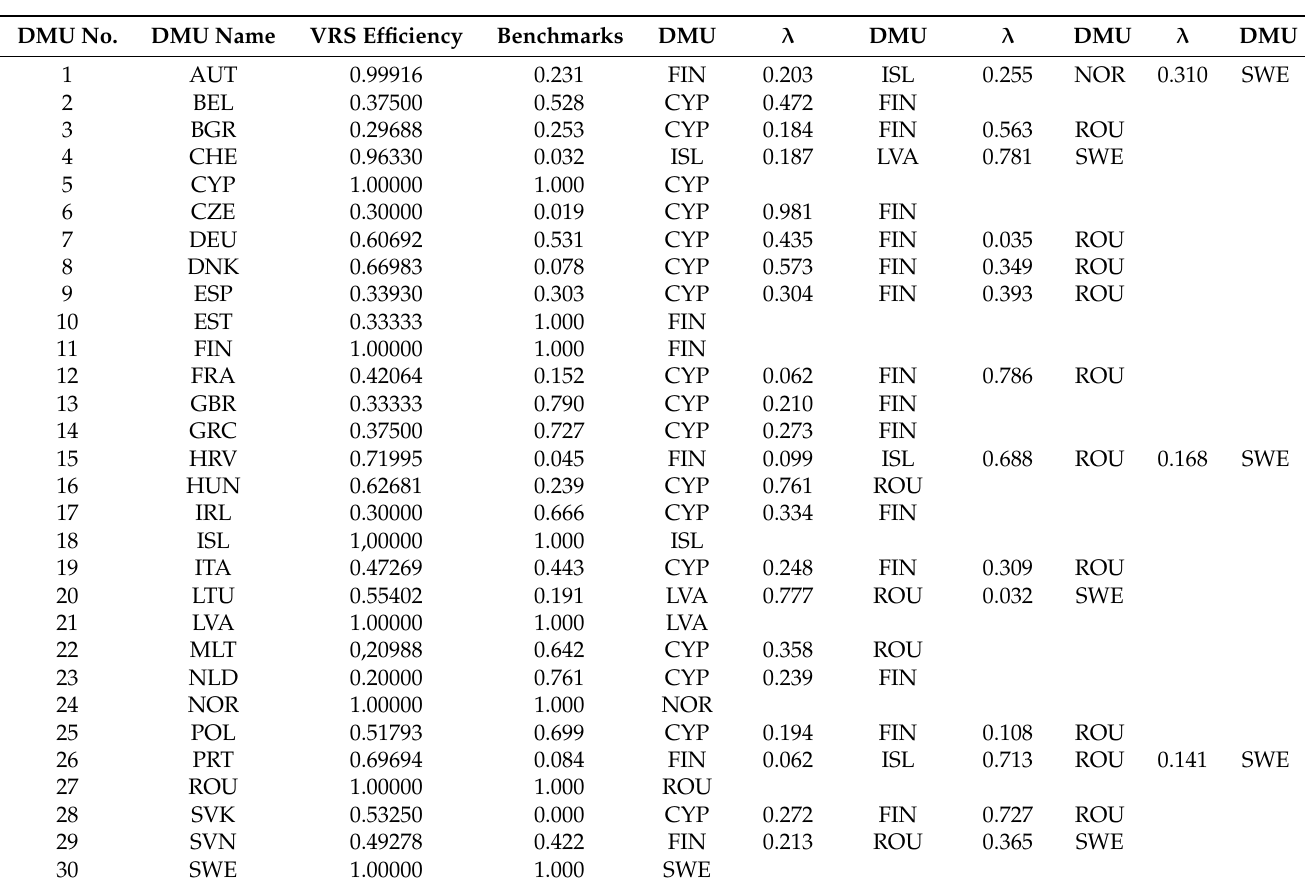
Table A16. Input-Oriented VRS Efficiency of EPS in 2007. Source: Authors’ calculations in DEAFrontier. DMU